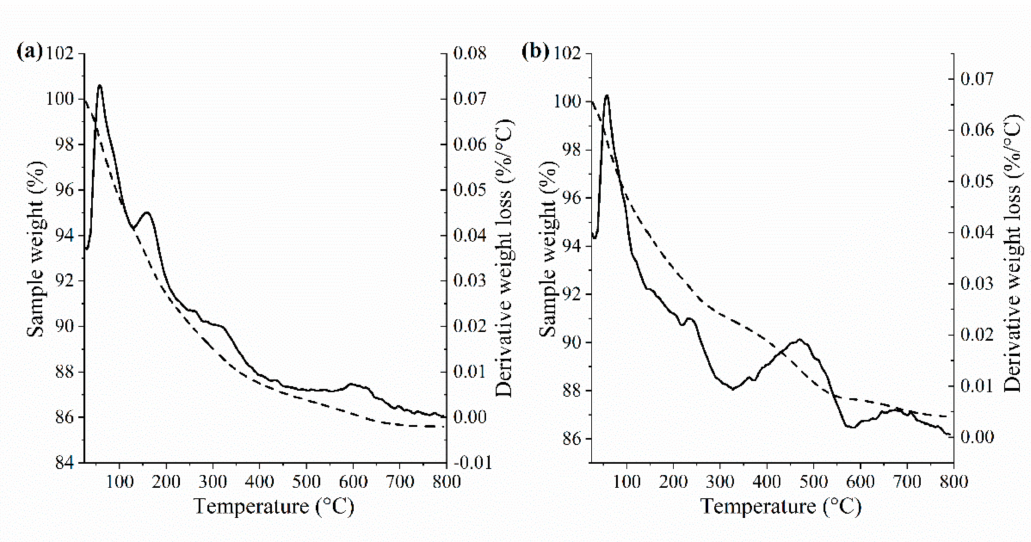
Figure 3. TG (dash) and DTG (solid) curves of CLI ( a ) and MAG-CLI ( b ).